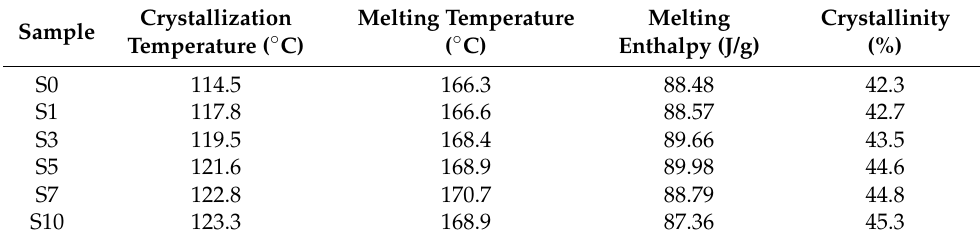
Figure 7. DSC crystallization curves of PP silica composites. Table 5. Thermal properties of PP/silica composites.